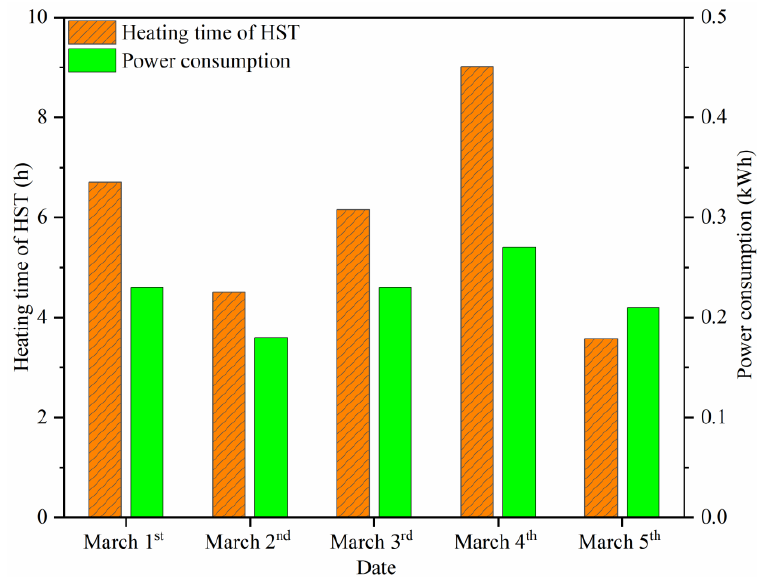
Figure 12. Heating hours and power consumption of HST.